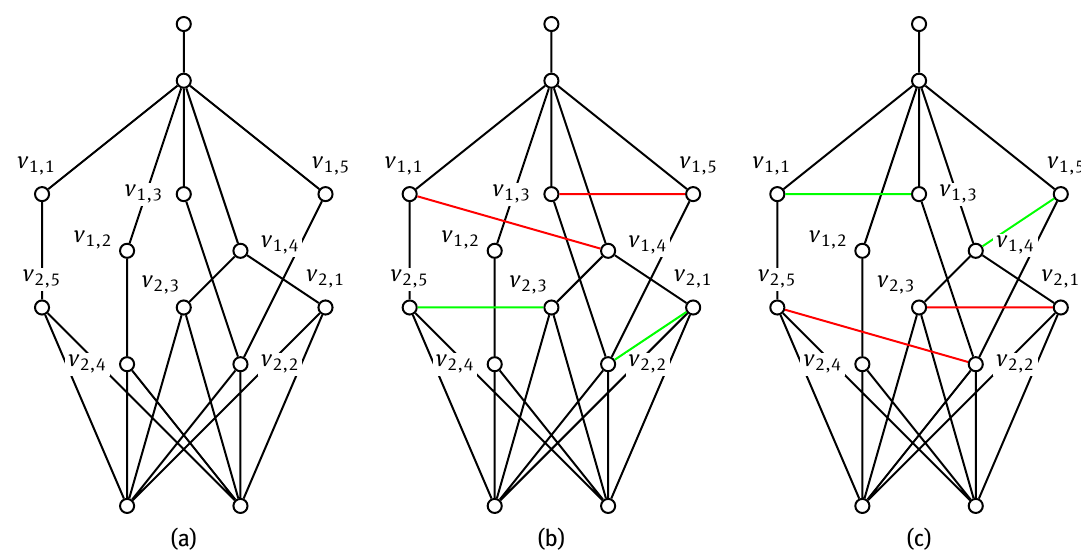
Figure 7: (a) A graph G with V 1 = { v 1,1 , v 1,2 , v 1,3 , v 1,4 , v 1,5 } a set of relaxed cousins to V 2 = { v 2,1 , v 2,2 , v 2,3 , v 2,4 , v 2,5 } . In